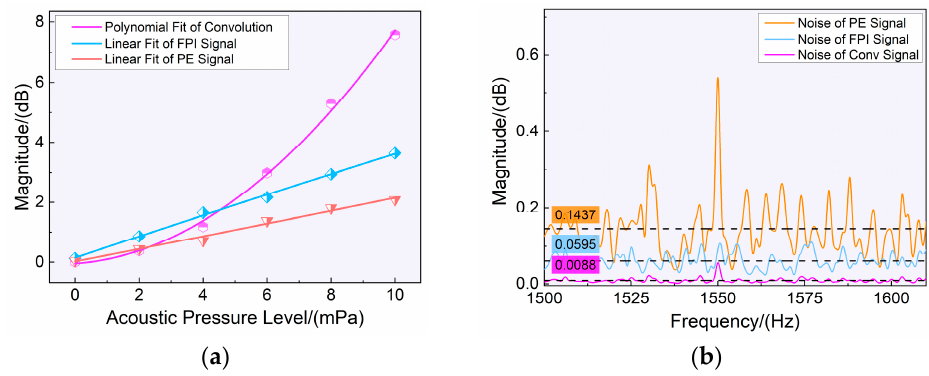
Figure 7. ( a ) The amplitude of the signal in the frequency domain and the amplitude after convolution at different sound pressure levels; ( b ) description of the noise level comparison.